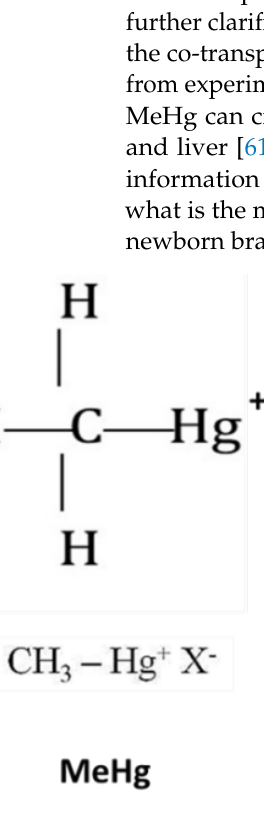
acid transporter subunits L-type amino acid transporter (LAT) 1 and rBAT (related to b 0,+ type amino acid transporter). The efflux transporter multidrug resistance-associated pro-